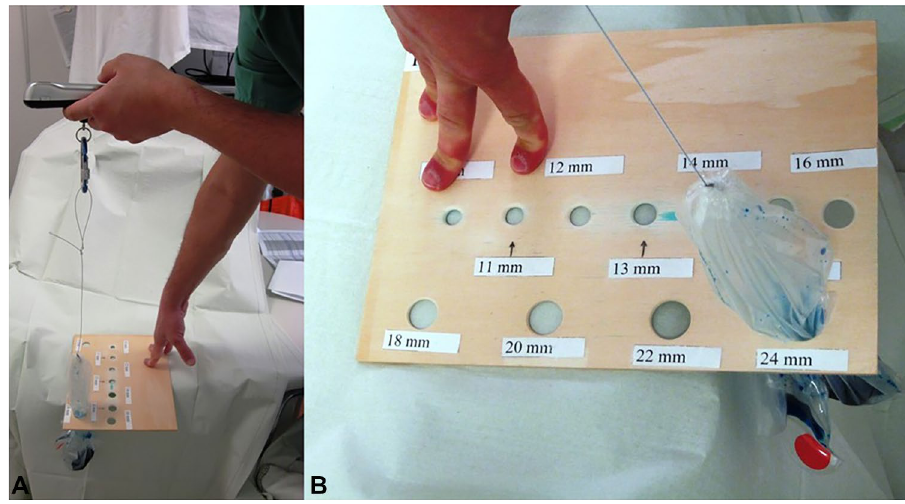
Figure 4. ( A ) and ( B ) Extraction of the endobag through the wooden